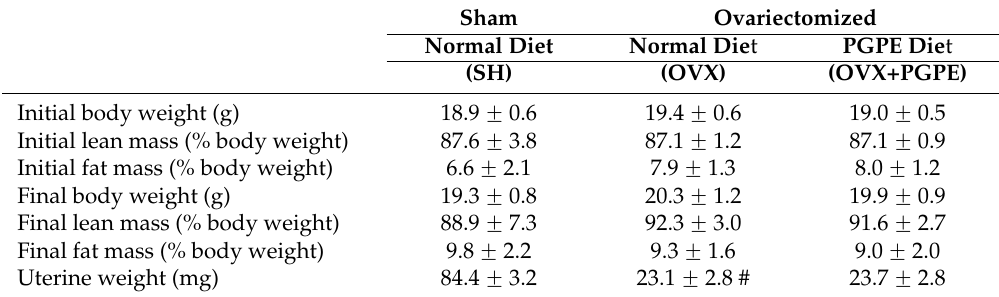
Table 1. Effect of ovariectomy and pomegranate peel extract consumption for 30 days on physiological parameters in mice. Sham